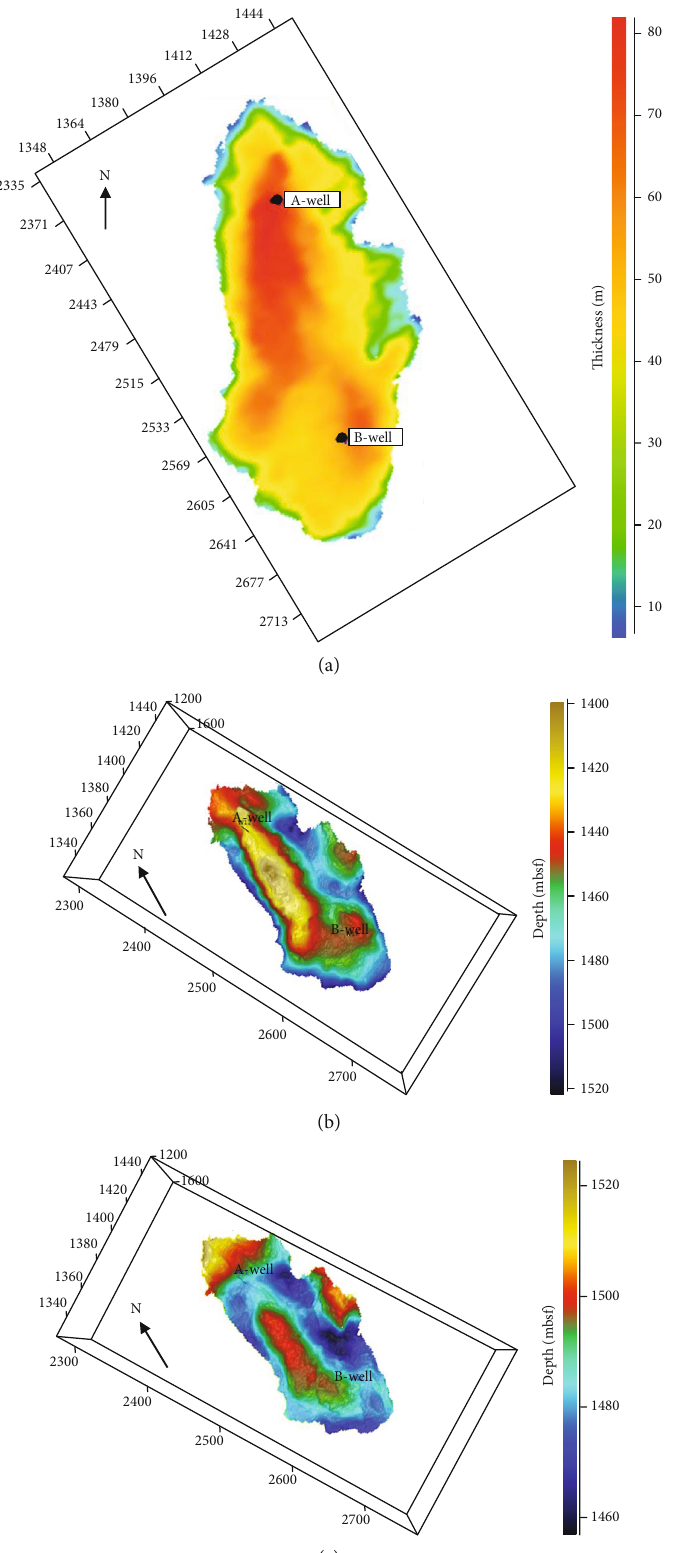
Figure 11: Thickness and spatial distribution of gas hydrate in the A-B ore body: (a) thickness distribution; (b) top surface structure; (c) bottom surface